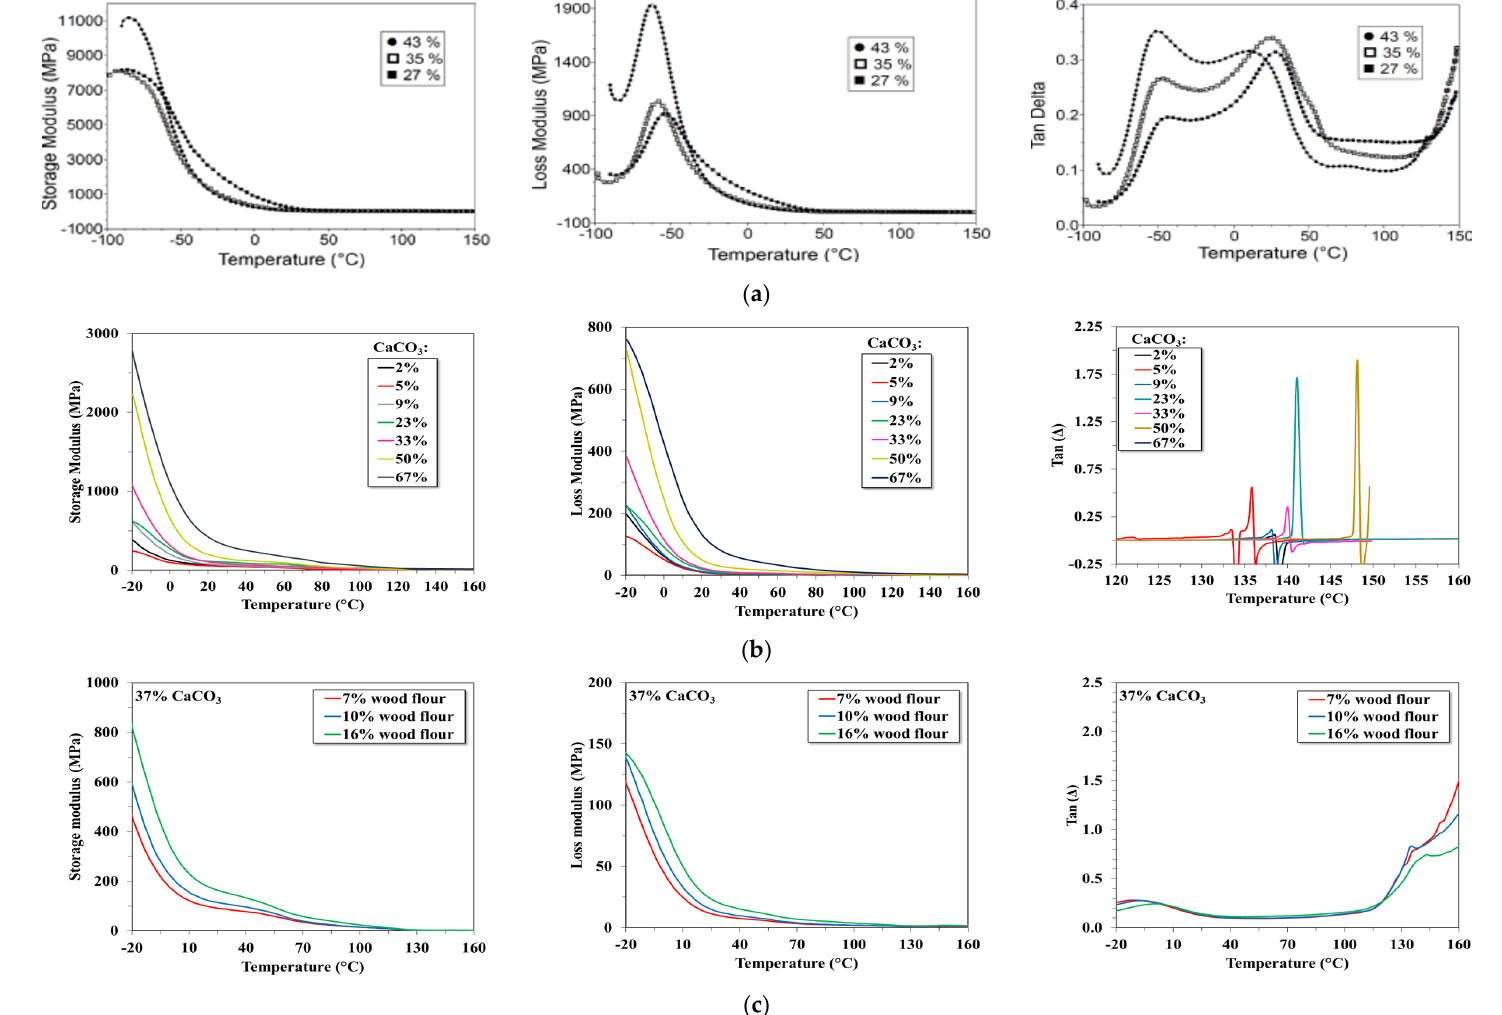
Figure 4. Dynamic-mechanical behaviour of binary, ternary, and quaternary starch-based blends ( a ) PVOH-starch; ( b ) PVOH-starch-CaCO 3 ; ( c ) PVOH-starch-CaCO 3 - wood flour.